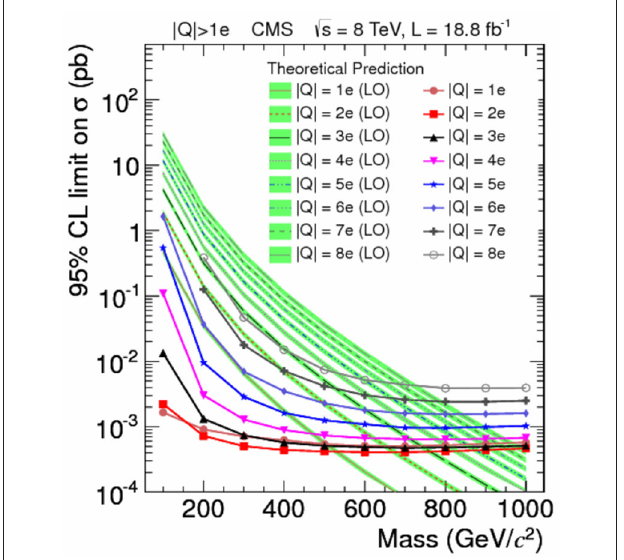
FIGURE 5 | Observed 95 % CL cross-section upper limits and theoretical cross-sections as functions of the multi-charged particles mass in CMS search at the √ s 8 TeV . The double charged particles are denoted as “ = The picture is taken with the according permission from Bulekov et al.